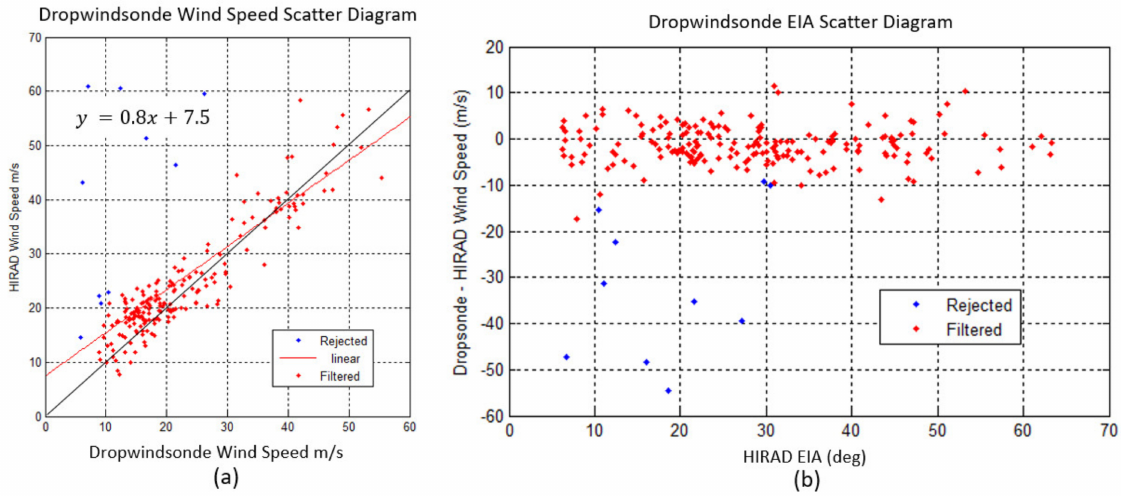
Figure 20. HIRAD comparisons with dropwindsondes as a function of wind speed ( a ) and dropwindsonde-HIRAD as a function of EIA ( b ). Red dots are the dropwindsondes used in the statistical analysis, while the blue dots are rejected.